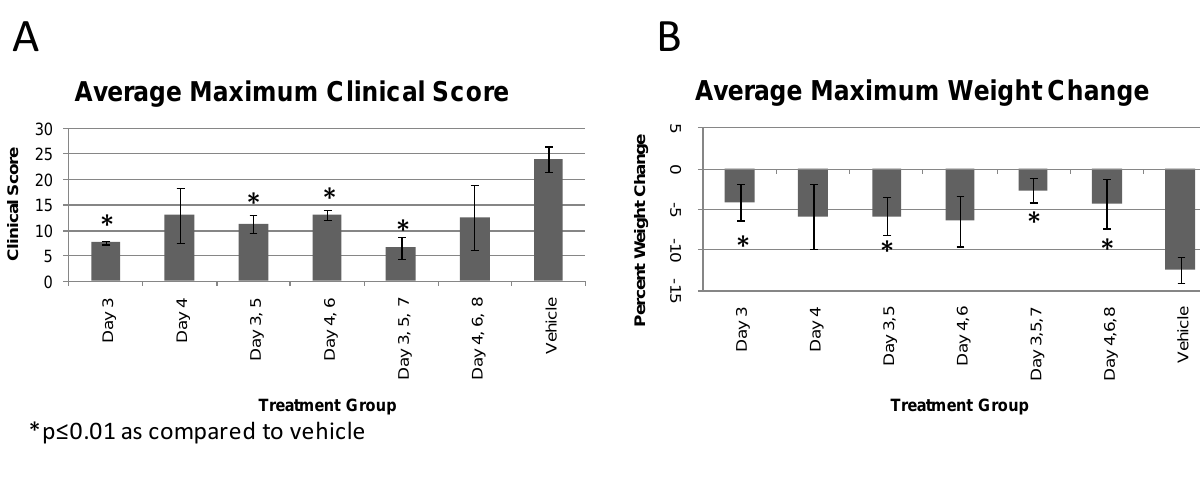
Figure 2. Disease severity measurements for evaluation of 1, 2 or 3 doses of CMX001 given every other day beginning at day 3 or 4 post infection. Animals were dosed at concentrations and schedules as outlined in Table 1. (A) Average of maximum clinical scores for each animal per group over the course of the experiment. (B) Average of maximum percent weight loss from weight at day 0 for each animal per group over the course of the